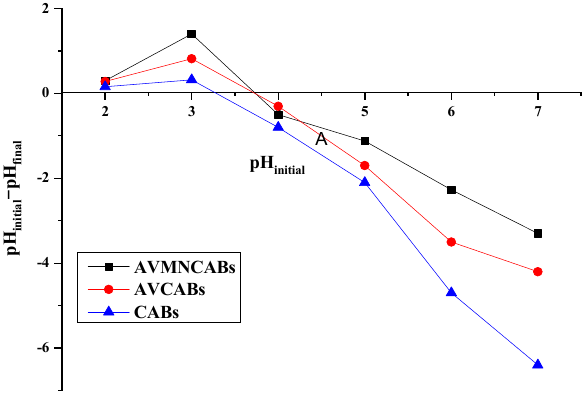
Figure 9. Point of zero charge (pH pzc ) of AVMNCABs, AVCABs, and